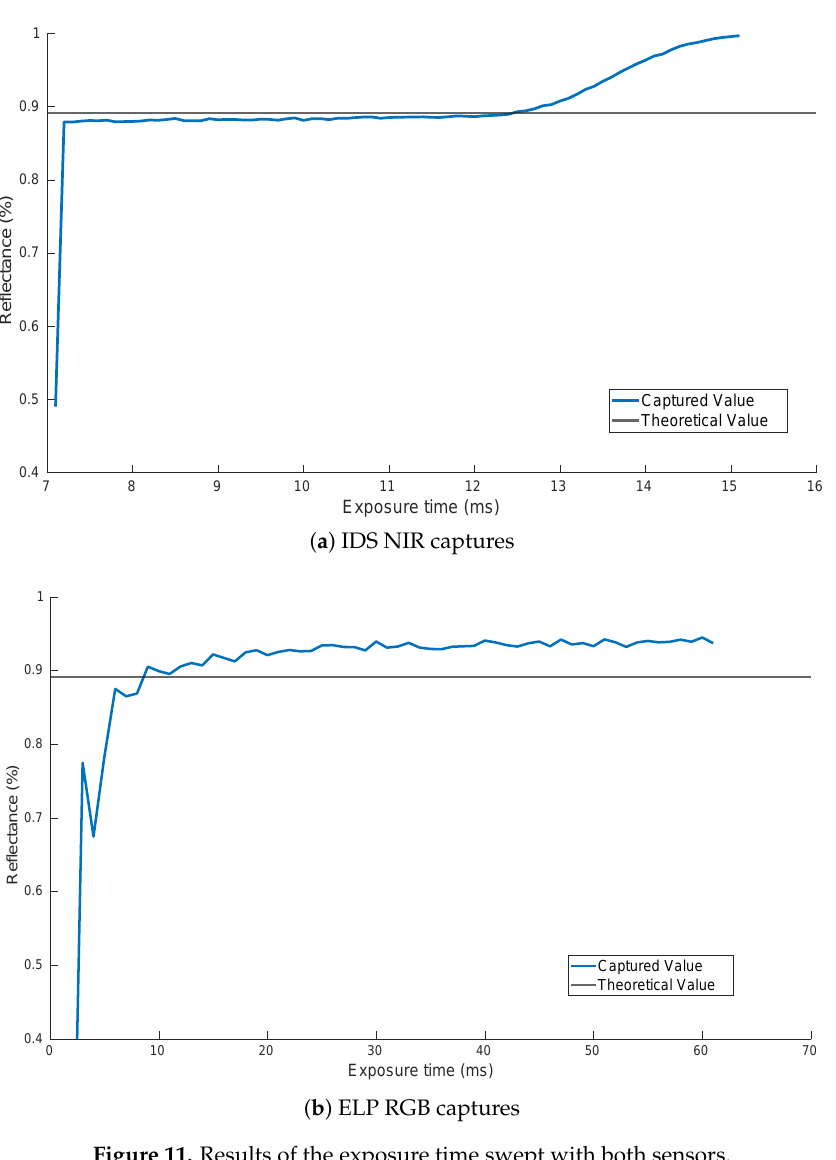
Figure 11. Results of the exposure time swept with both